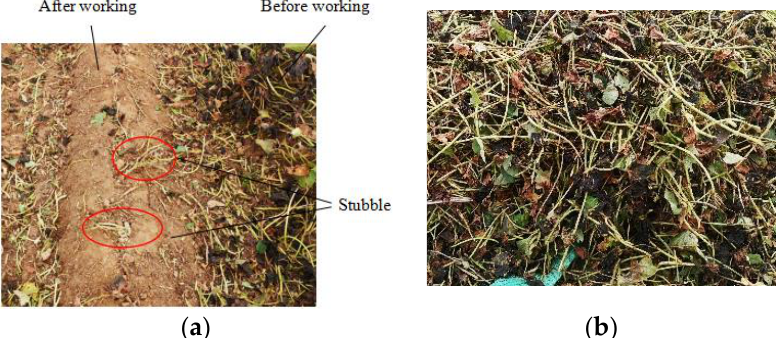
Figure 15. Field operation effect after optimization: ( a ) field conditions before and after working; ( b ) harvested sweet potato vines.